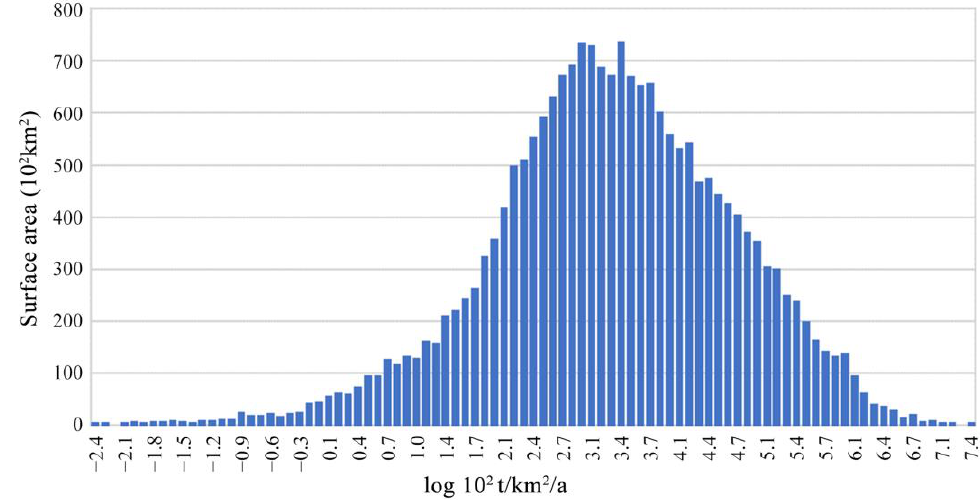
Figure 10. Soil Erosion Hazard (Log A) Distribution of Chongqing City in 2020. Figure 9. Soil Erosion Hazard (Log A) Distribution of Chongqing City in